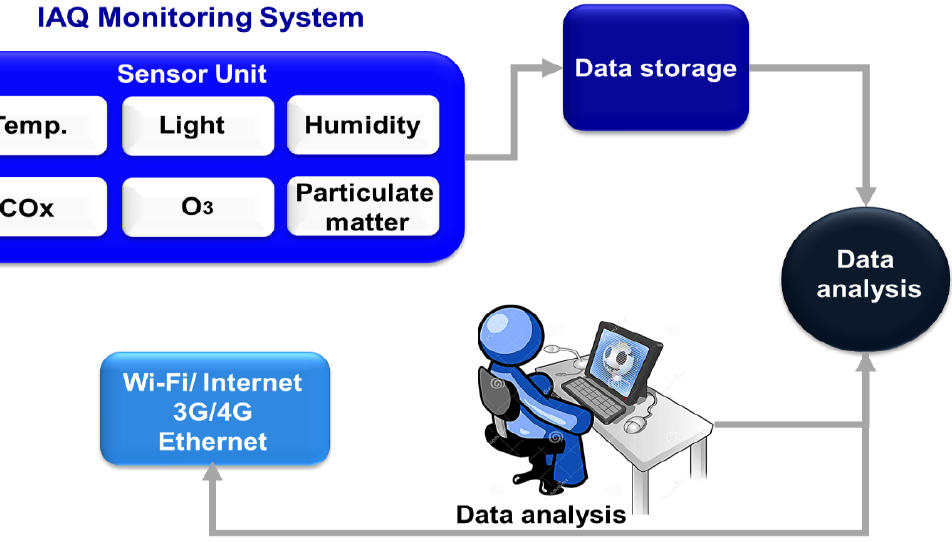
Figure 3. General conceptual architecture of IAQ monitoring system.